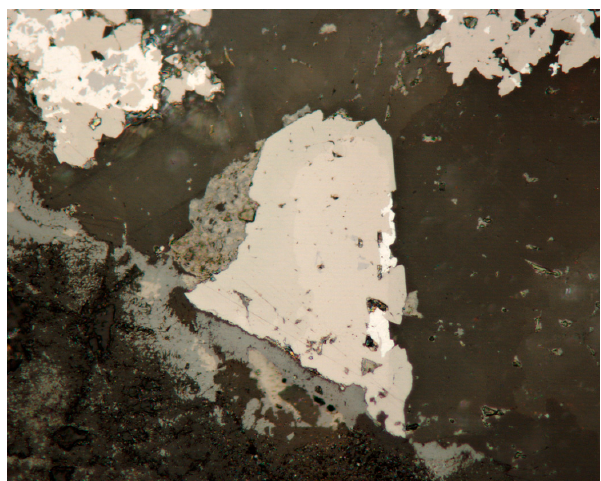
Figure 61. The core of the zonal aggregate is formed by new Hg-Cu-Sb selenide and Hg-hakite (indistinguishable from each other in the ore microscope); the rim is grey tetrahedrite. Bluish-grey uraninite and white anhedral grains of tiemannite are the oldest phases in the association. Reflected light, one polarizer. FOV 210 μ m. P ř íbram, a dump of shaft 16. Photo by P. Škácha.